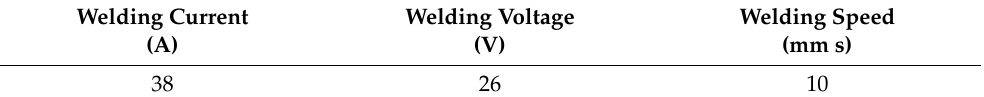
Table 3. Welding process parameters.